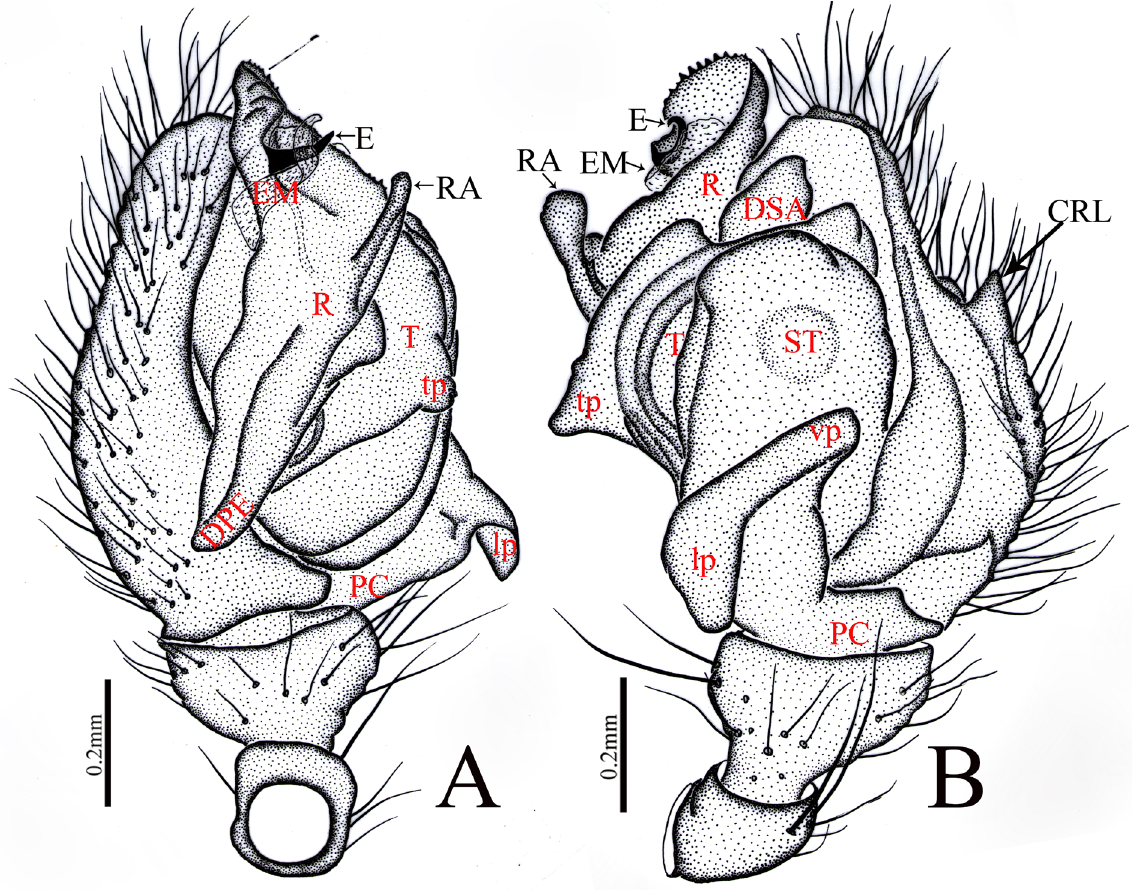
Fig. 26. Acroterius latus gen. et sp. nov., ♂, holotype (HNU-CGY123), palp. A . Prolateral view. B . Retrolateral